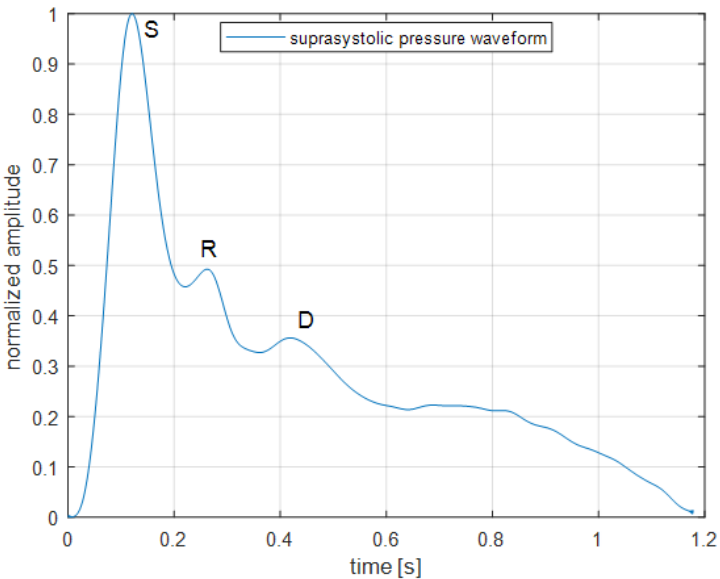
Figure 1. Suprasystolic pressure waveform: S—maximum of the pulsation (during systolic phase), R—reflected wave from aortic bifurcation, D—reflected wave from lower body (diastolic phase of the cardiac cycle).